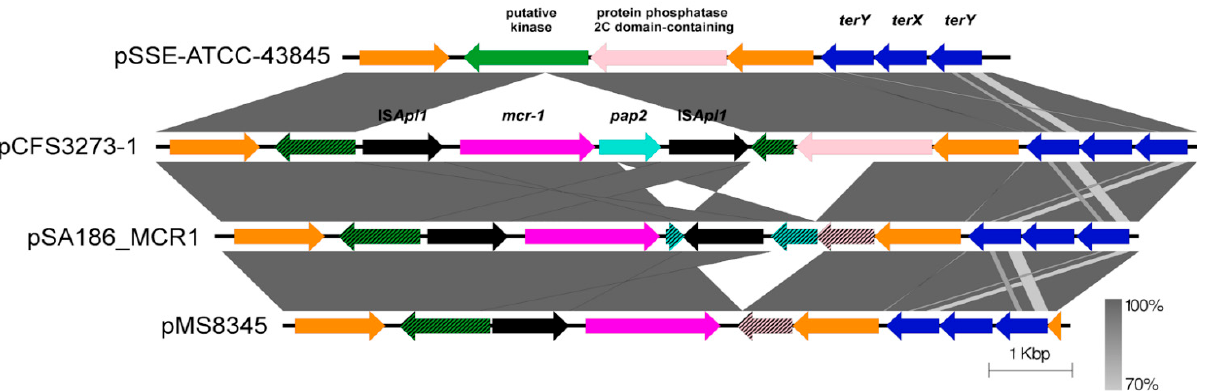
Figure 2. Genetic map showing the ISAp1 mcr-1 transposon Tn 6330 in plasmid pCFS3292-1 and pCFS3273-1 compared to the reference Tn 6330 described by Li et al. in pHYEC7- mcr1 . Each colour represents a different gene as specified in the figure. Orange colour represents “other genes”.